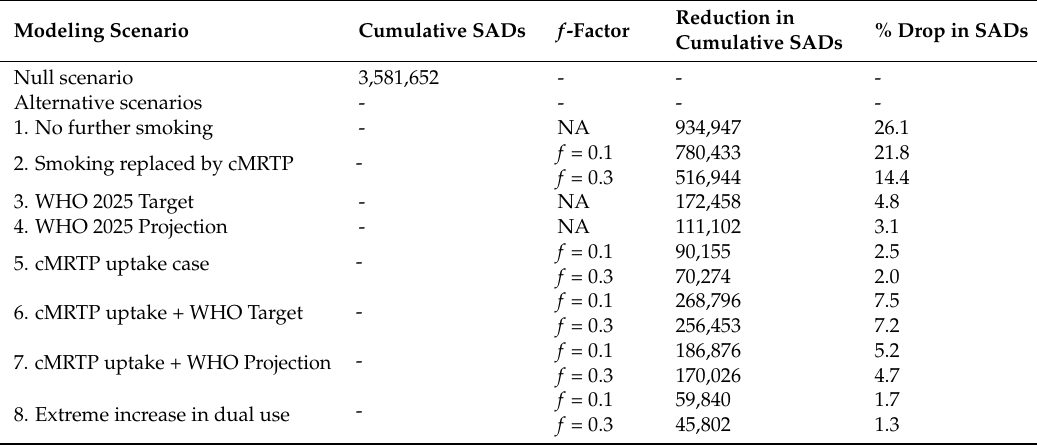
Table 2. Reduction in cumulative SADs for the various alternative scenarios (data for both sexes and the four diseases